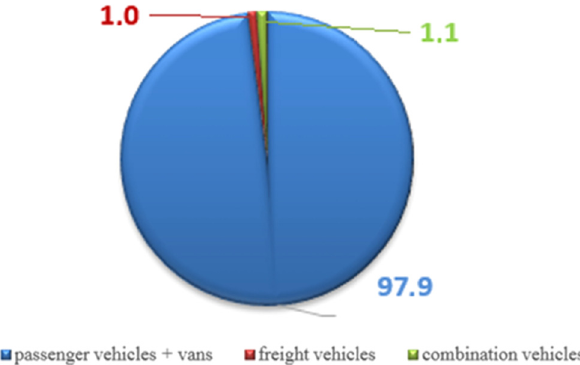
Figure 9: The ratio of the individual vehicles categories ( 3rd survey )